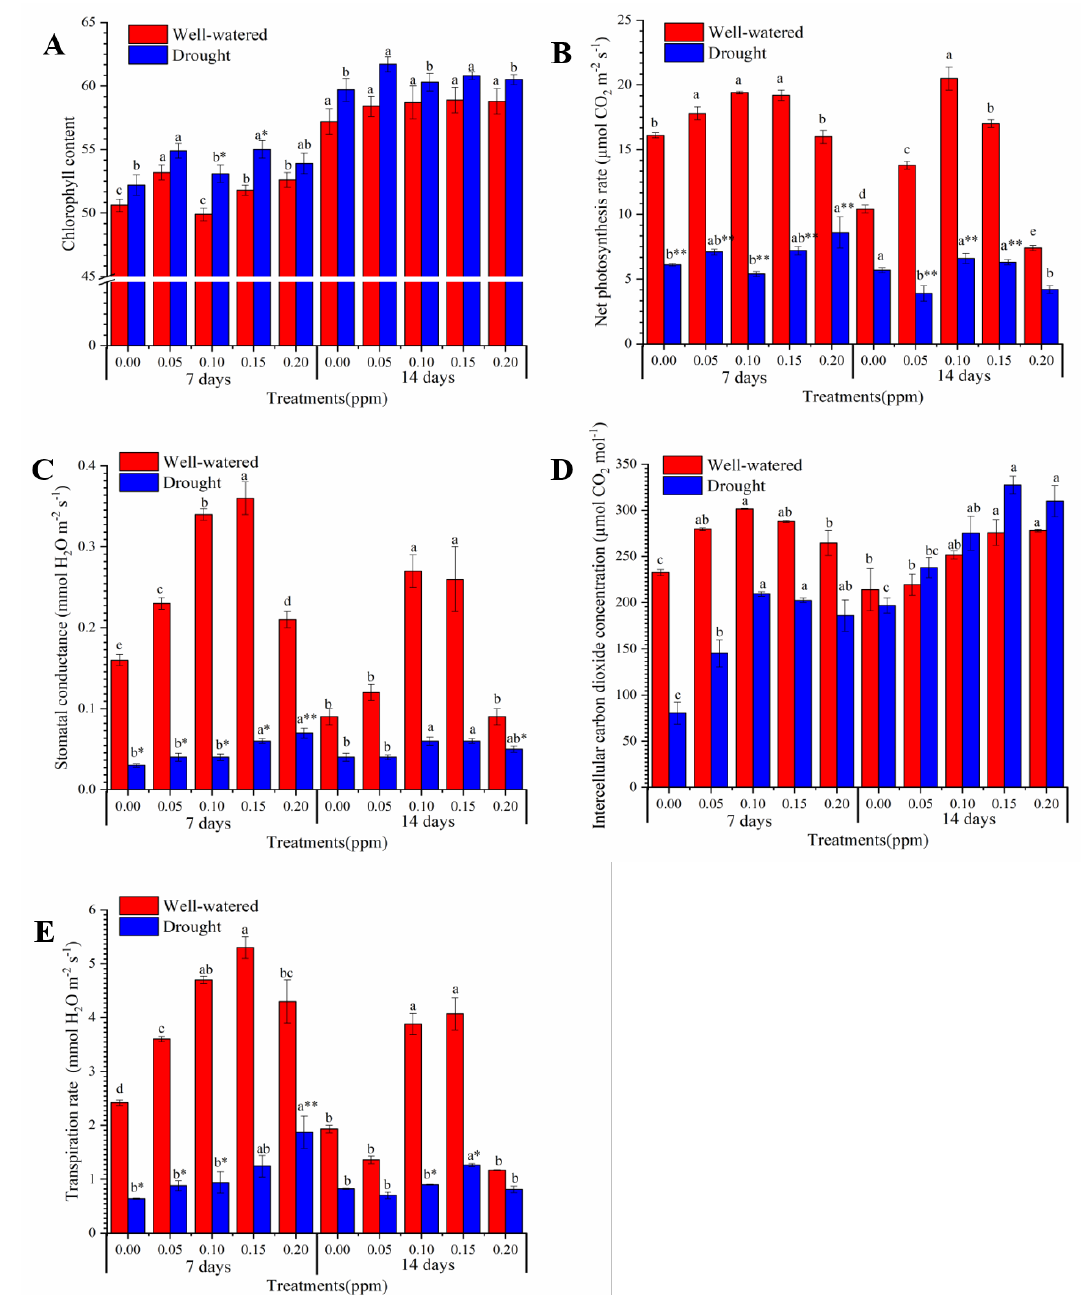
Figure 2. Physiological changes in photosynthesis induced by brassinolide priming under well-watered and drought conditions. ( A ) Chlorophyll content; ( B ) Net photosynthesis rate; ( C ) Stomatal conductance; ( D ) Intercellular carbon dioxide concentration; ( E ) Transpiration rate. Data are presented as mean ± standard error ( n = 3). Di ff erent letters above the bar indicate the statistically significant di ff erence among the five brassinosteroid (BR) priming at 7 days of drought treatments and 14 days of drought treatment, respectively as determined by the least significant di ff erence test. * and ** represent the statistically significant di ff erence at p < 0.05 and p < 0.01, respectively, between drought treatment and well-watered treatment. BR priming concentrations were set to 0.00, 0.05, 0.10, 0.25, and 0.20 ppm. 7 days, 7 days of treatment; 14 d, 14 days of treatment.